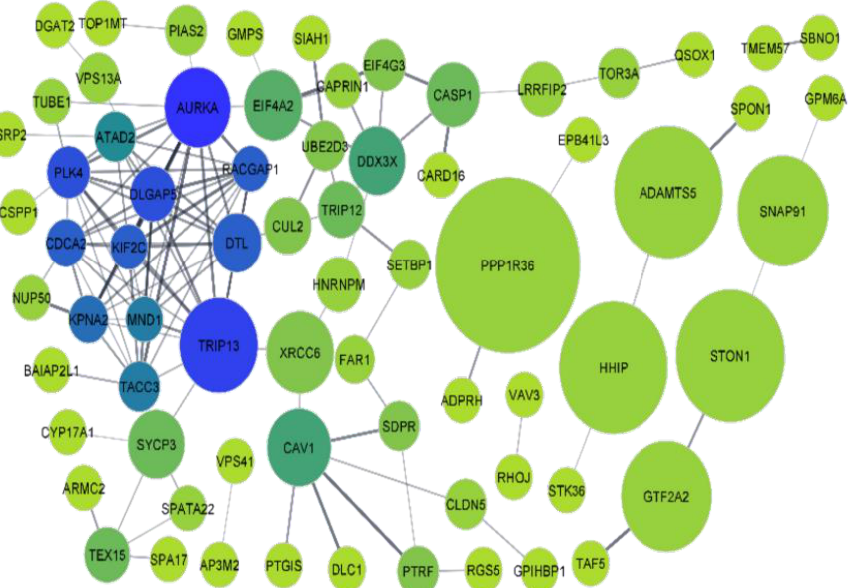
Figure 8. The Protein-Protein Interaction (PPI) network common to teratozoospermia and azoospermia using the STRING application of Cytoscape. The node size is directly proportional to the betweenness centrality value of the particular protein while the node color is based on the degree of connectivity of the different nodes with other neighboring nodes.